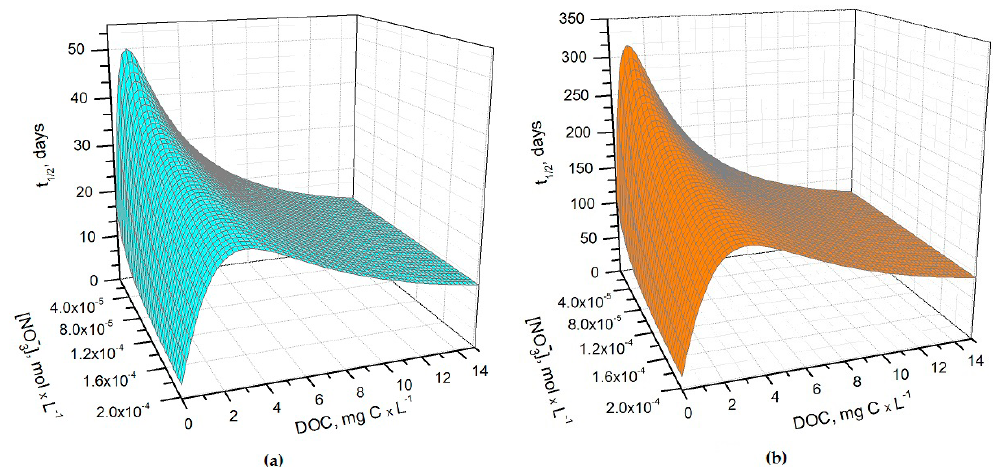
Figure 1. ( a ) Photochemical half-life time ( t 1/2 ) of H 3 AsO 3 in rice field water in May. Water conditions: 5 cm depth; 1 μ M NO 2 − , 1 mM bicarbonate, 10 μ M carbonate, and 0.53 sunlight transmittance; ( b ) Photochemical half-life time of H 3 AsO 3 in rice field water in June. Water conditions: 5 cm depth; 1 μ M NO 2 − , 1 mM bicarbonate, 10 μ M carbonate and 0.08 sunlight